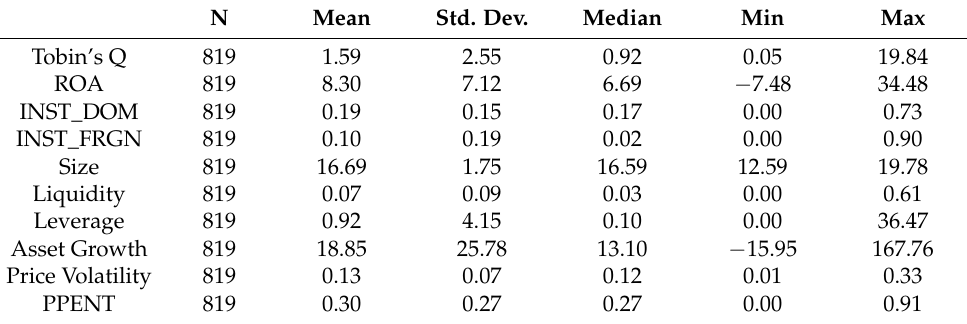
Table 2. Summary statistics.